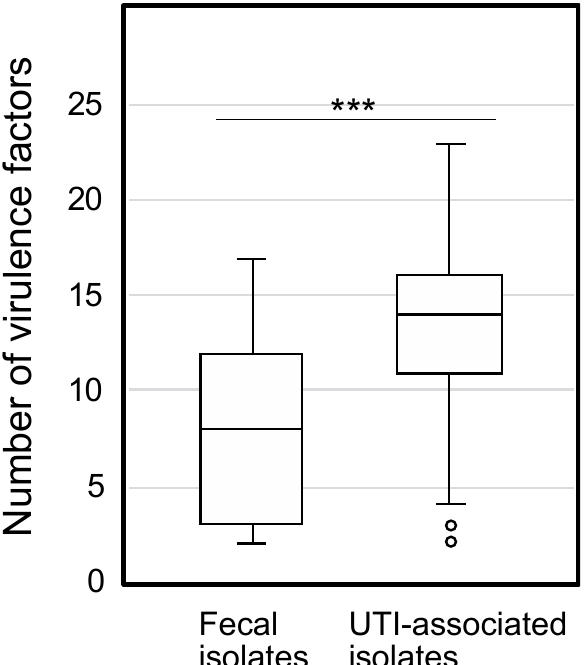
Figure 1. The number of virulence factors in clinically isolated E. coli . The boxplot indicates the number of VFs in fecal and UTI-associated isolates. The numbers of VFs between fecal and UTI- associated isolates (average 8.1 and 13.2, respectively) show a significant difference by the Mann- Whitney U test (***, p < 0.001).